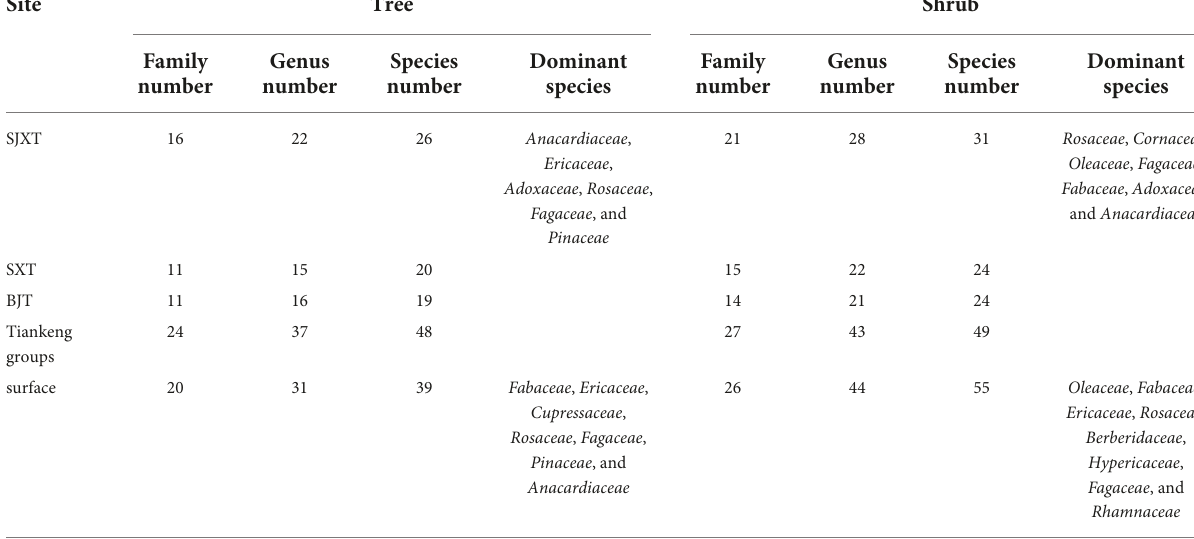
TABLE 2 Floristic composition of trees and shrubs in the karst tiankeng groups and the surface.